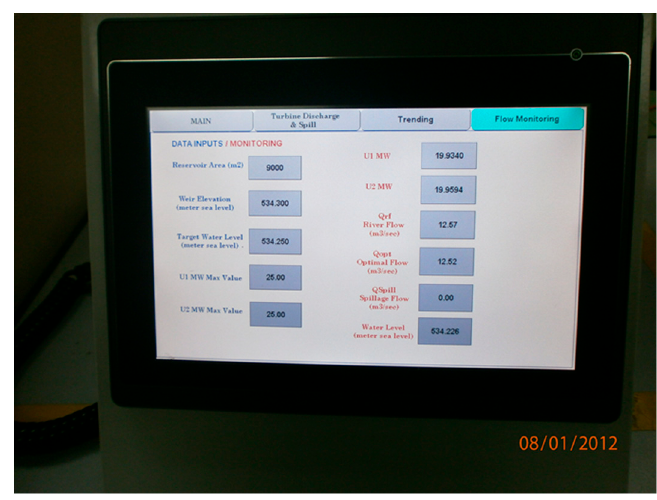
Figure 10. HMI: a sample of HMI graphic page.